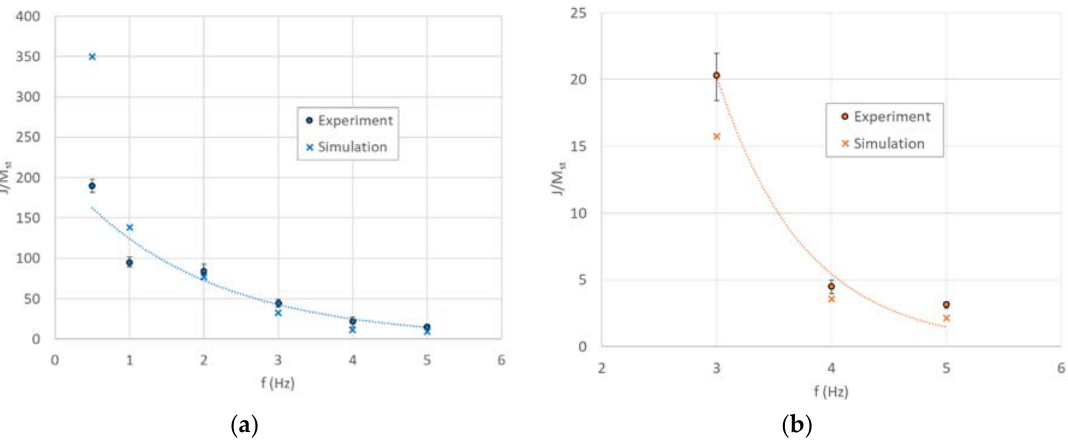
Figure 19. Comparison of experimental and simulated specific inertance for ( a ) Displacement-Controlled Sinusoidal Excitation (DCSE) and ( b ) Acceleration-Controlled Sinusoidal Excitation (ACSE).